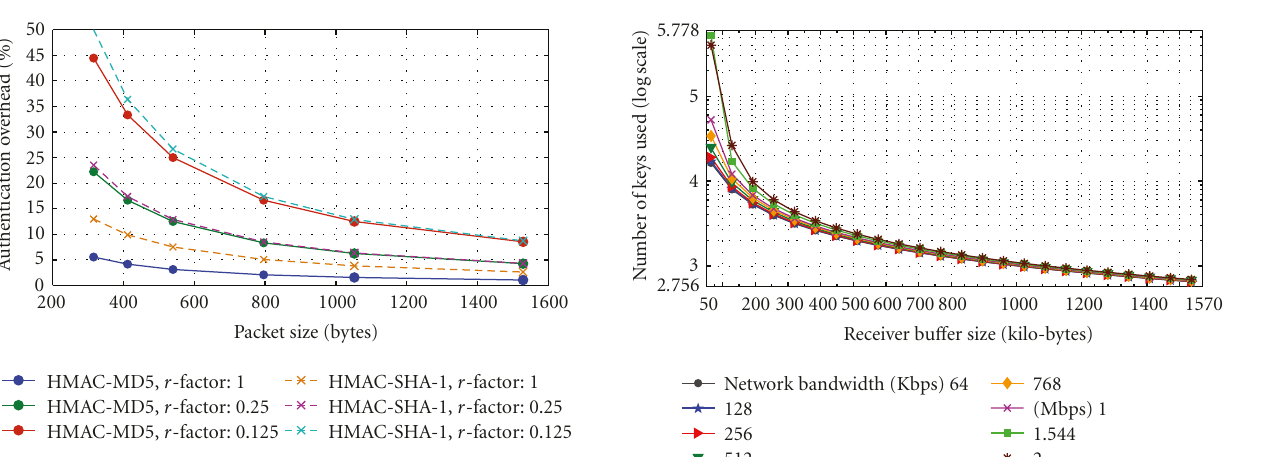
Figure 9: Percentage size overhead comparison between HMAC- MD5 and HMAC-SHA1, 500MB data. Figure 10: Number of keys required for authenticating 1